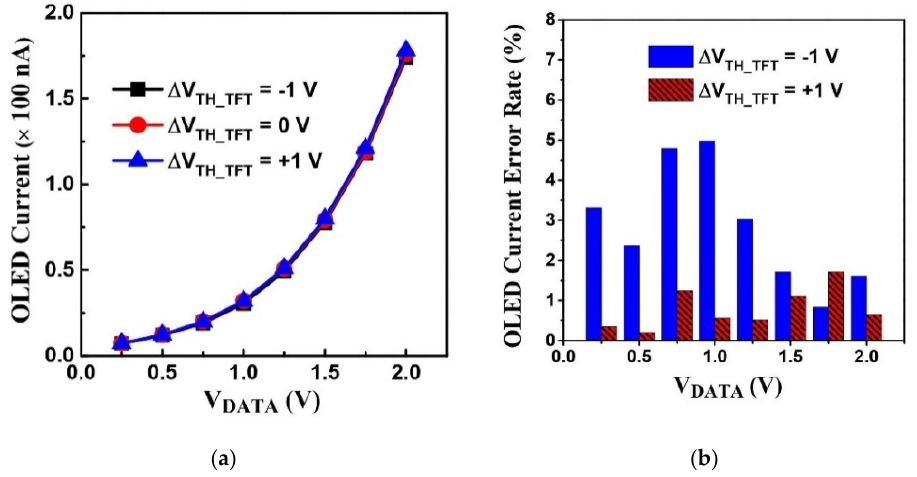
Figure 5. ( a ) Driving currents versus data voltage with ± 1 V variation in V TH_TFT . ( b ) OLED current error rates with ± 1 V variation in V TH_TFT .